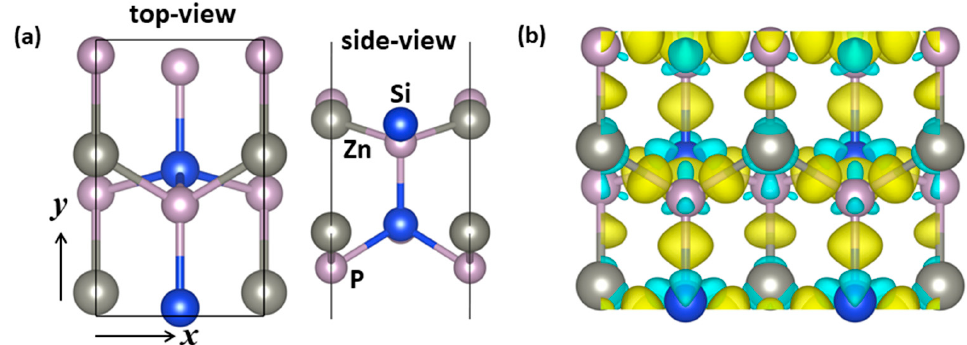
Figure 1. ( a ) The lowest-energy geometry of the ZnSiP 2 monolayer, with top and side views.( b ) The charge density difference of the ZnSiP 2 monolayer. (The gold coloring (i.e., 0.01 e/Å 3 ) in the plot indicates an electron-density increase after bonding, and the cyan coloring (i.e., 0.01 e/Å3) indicates a decrease.) Zn atoms are gray, Si atoms blue and P atoms pink.